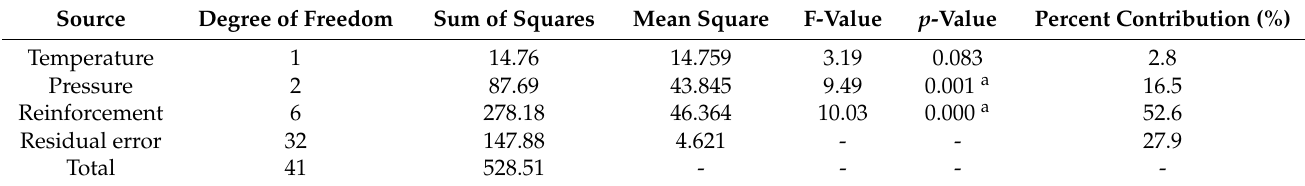
Table 4. Analysis of variance for S/N ratios of surface roughness (Ra).